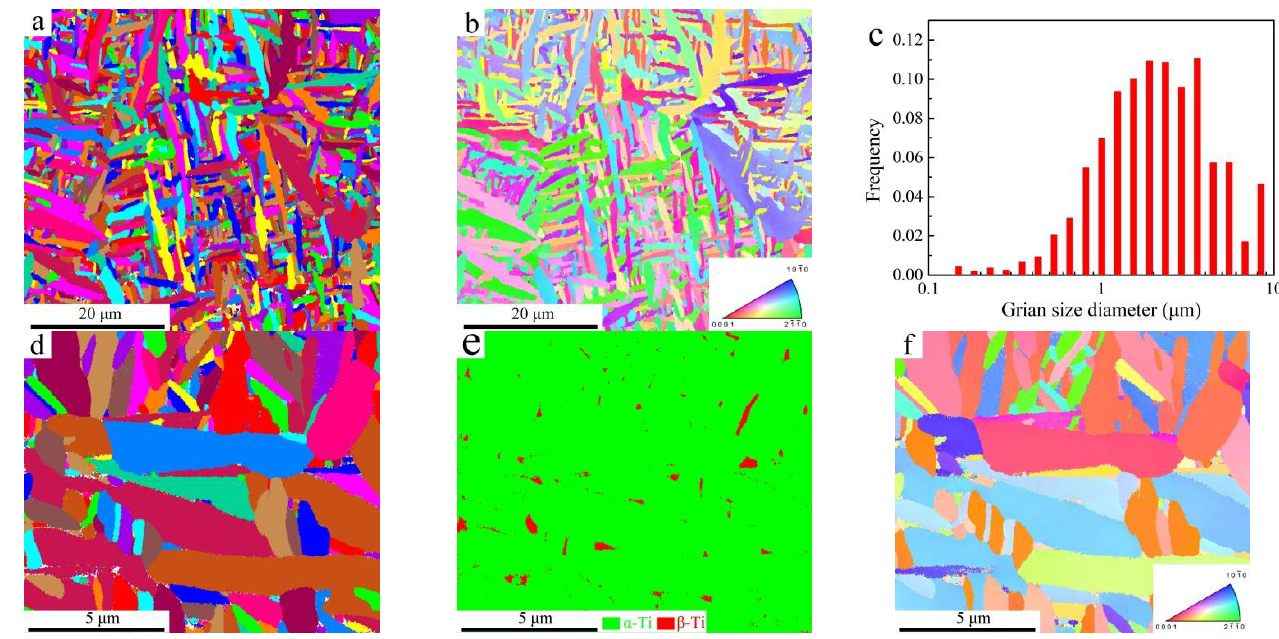
Figure 6. PBF-EB AM Ti6Al4V alloy with linear and 90° rotate scanning strategy (sample B): ( a ) Grain size and ( b ) IPF images at low magnification; ( c ) grain size, ( d ) phase map, and ( e ) IPF figures at high magnification. The color of the inset figure in ( b , f ) represents grains orientation.